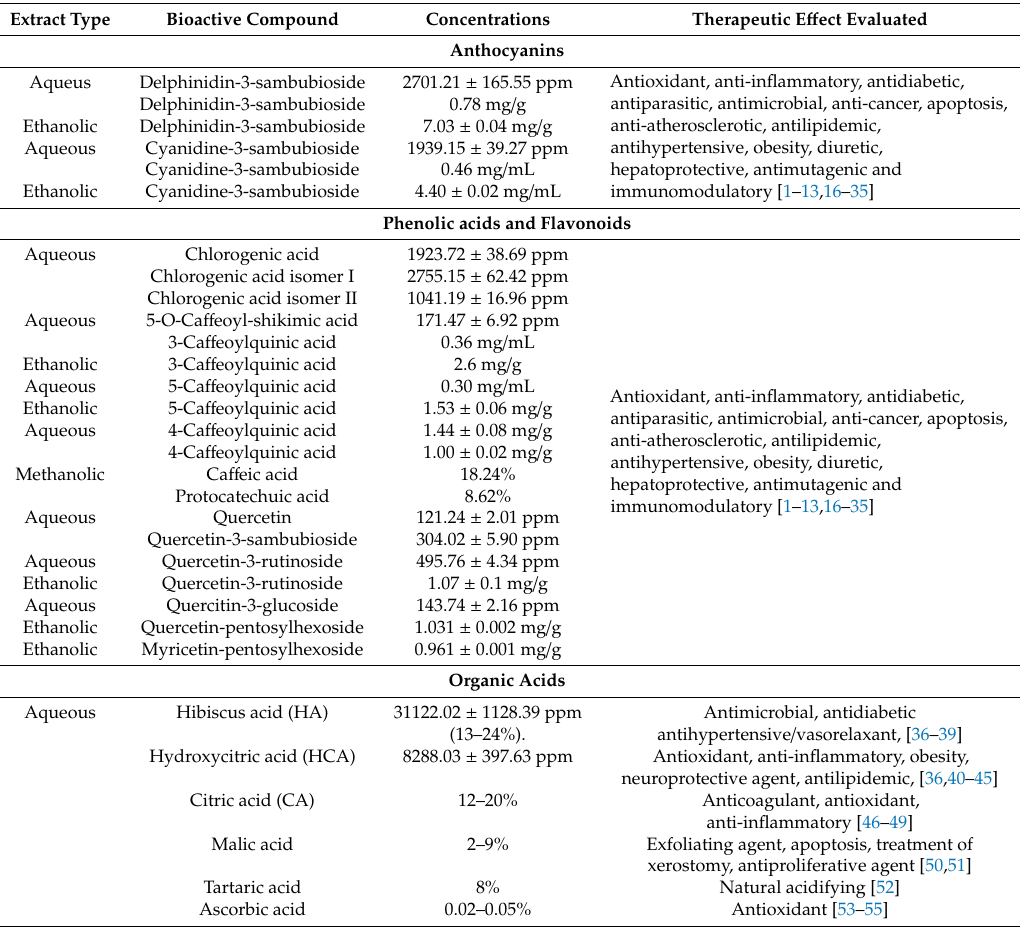
Table 2. Therapeutic e ff ects and concentrations of some bioactive compounds from extracts of Hibiscus sabdari ff a L.